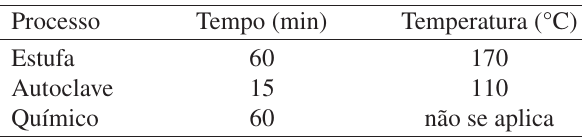
Tabela 2. Tempo e temperatura utilizados nos processos de esterilização.